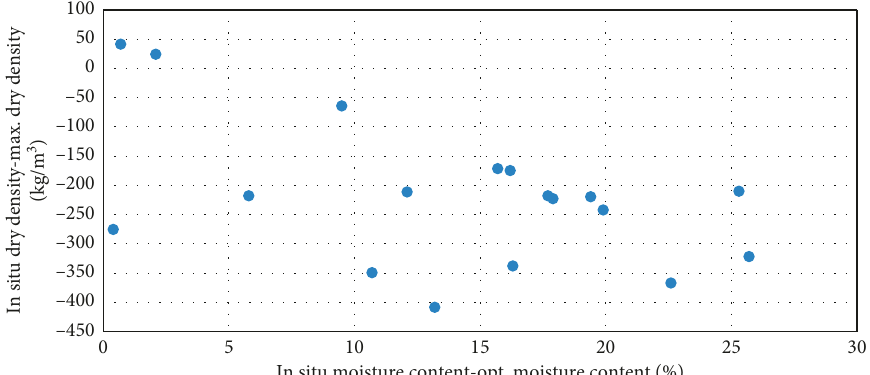
Figure 4: In situ moisture content-optimum moisture content versus in situ dry density-maximum dry density.